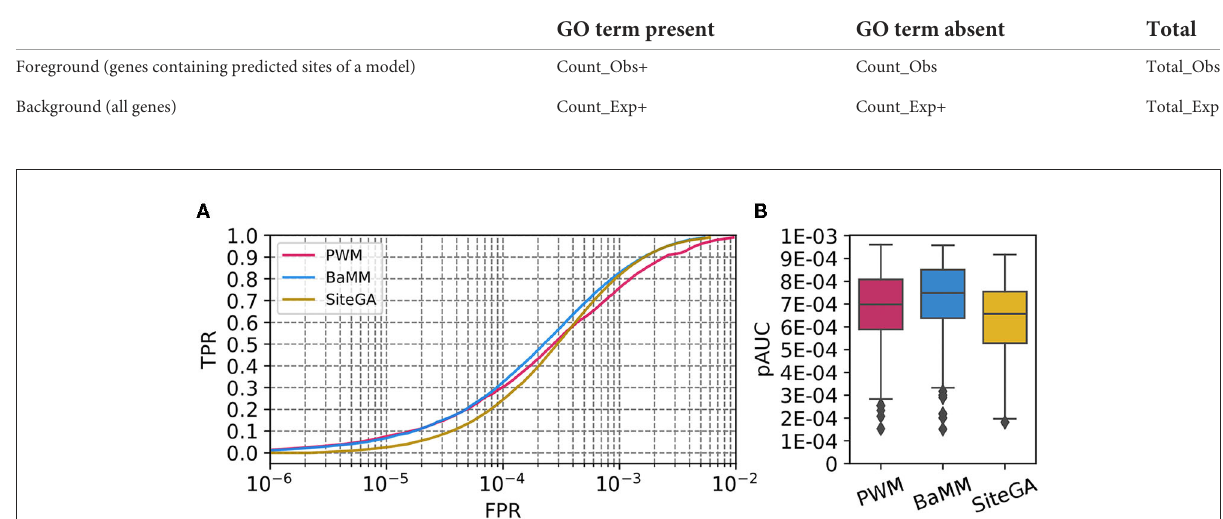
FIGURE1 Performances of PWM, BaMM, and SiteGA motif recognition models for the benchmark collection of 111 A. thaliana ChIP-seq datasets. (A) ROC curves for the model’s performance. We applied the bootstrap cross-validation procedure (see Section 2) and computed for each TPR (axis Y), the average FPRs (axis X) for the benchmark collection. (B) Boxplot distribution of the performance measure pAUC for three models. The boxplot presents the distributions of the Q 1 , Q 2 , and Q 3 quartiles of the fractions of the peaks with recognized TFBS. Whiskers below/above the Q 1 / Q 3 respect the minimum/maximum values if they were located within 1.5 interquartile ranges ( IQR = Q 3 − Q 1 ) from Q 1 / Q 3 , otherwise they are equal to { Q 1 − 1.5 ∗ IQR } / { Q 3 + 1.5 ∗ IQR } , respectively. In the latter case, we marked all other points as outliers.